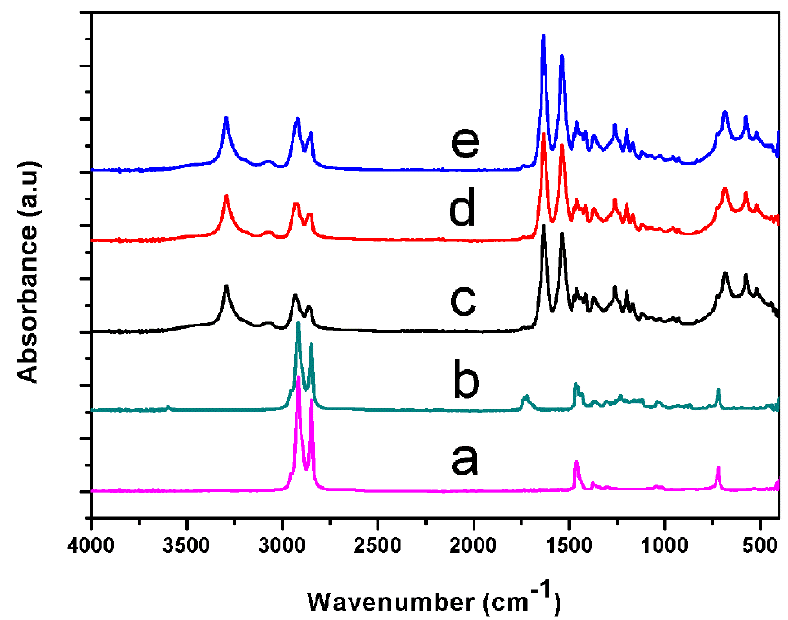
Figure 2. Fourier transform infrared (FTIR) spectra of ( a ) pure OBC, ( b ) pure POE-g-MAH, ( c ) pure PA6, ( d ) the uncompatibilized PA6/OBC blend, and ( e ) the 7 wt% POE-g-MAH compatibilized PA6/OBC blend (PA6/OBC/7).